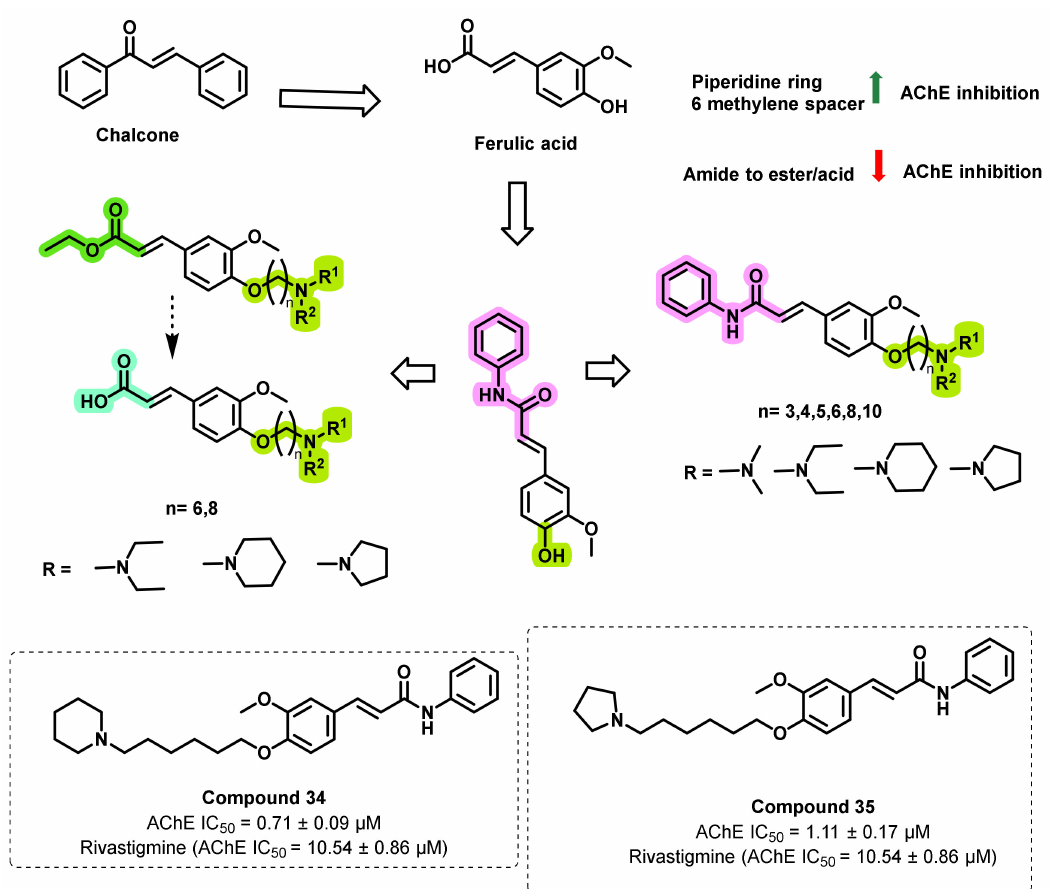
Figure 32. Ferulic acid-inspired chalcone derivatives.